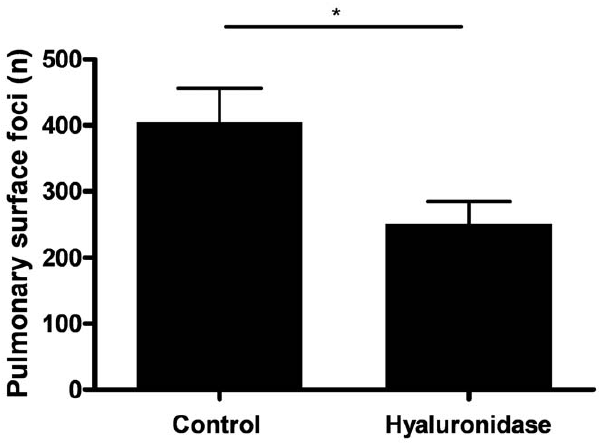
Figure 1. Effect of hyaluronidase on the number of B16F10 pulmonary tumor foci. C57Bl/6 mice were treated intravenously with 100U hyaluronidase 1h prior to the administration of 3.5 6 10 5 B16F10 melanoma cells into the lateral tail vein. Mice were sacrificed 14 days after cancer cell injection and the number of tumor foci at the surface of the lungs was determined. Error bars represent means 6 SEM (n=8); *, p , 0.05.